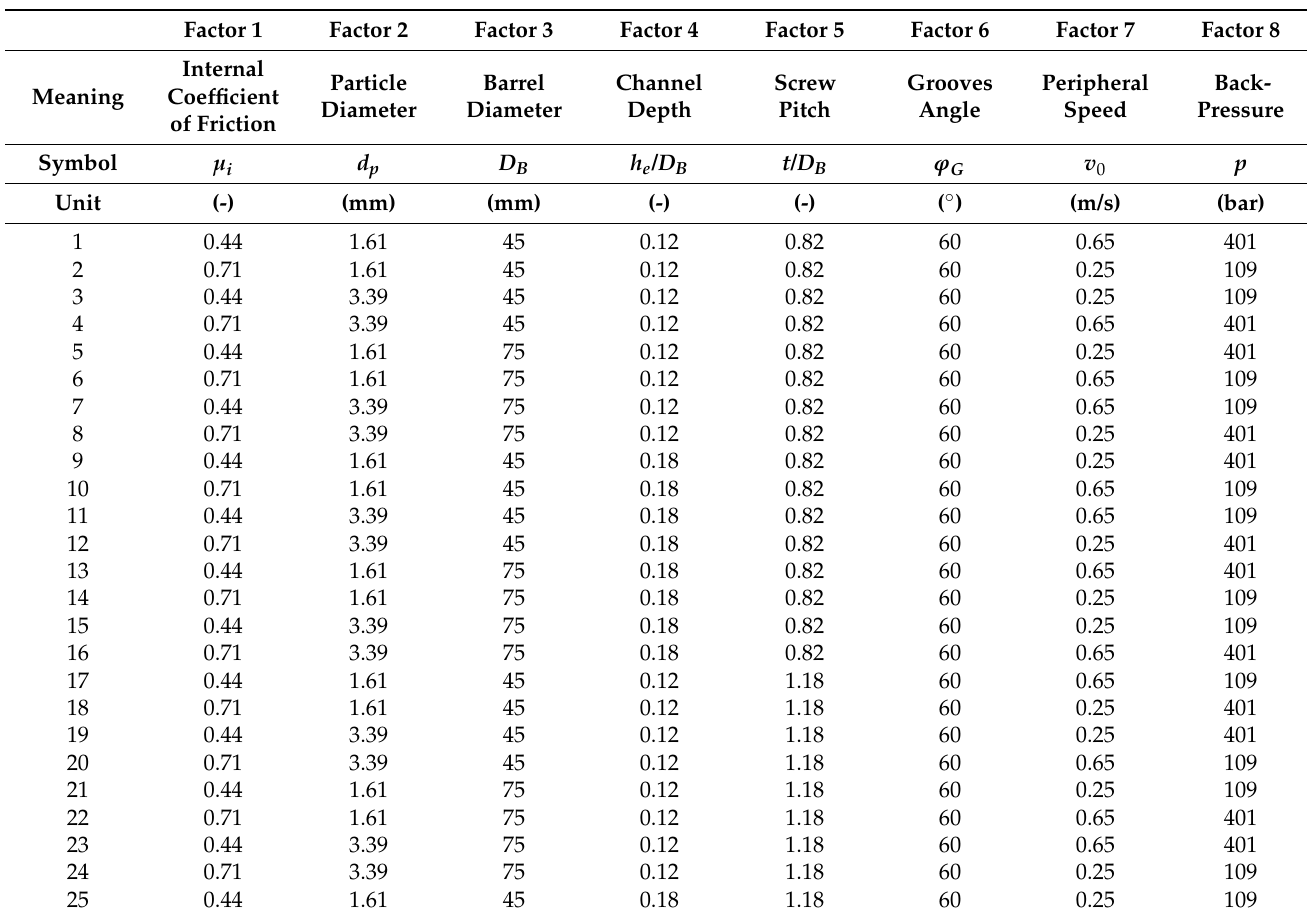
Table A3. Design of Experiments for Numerical